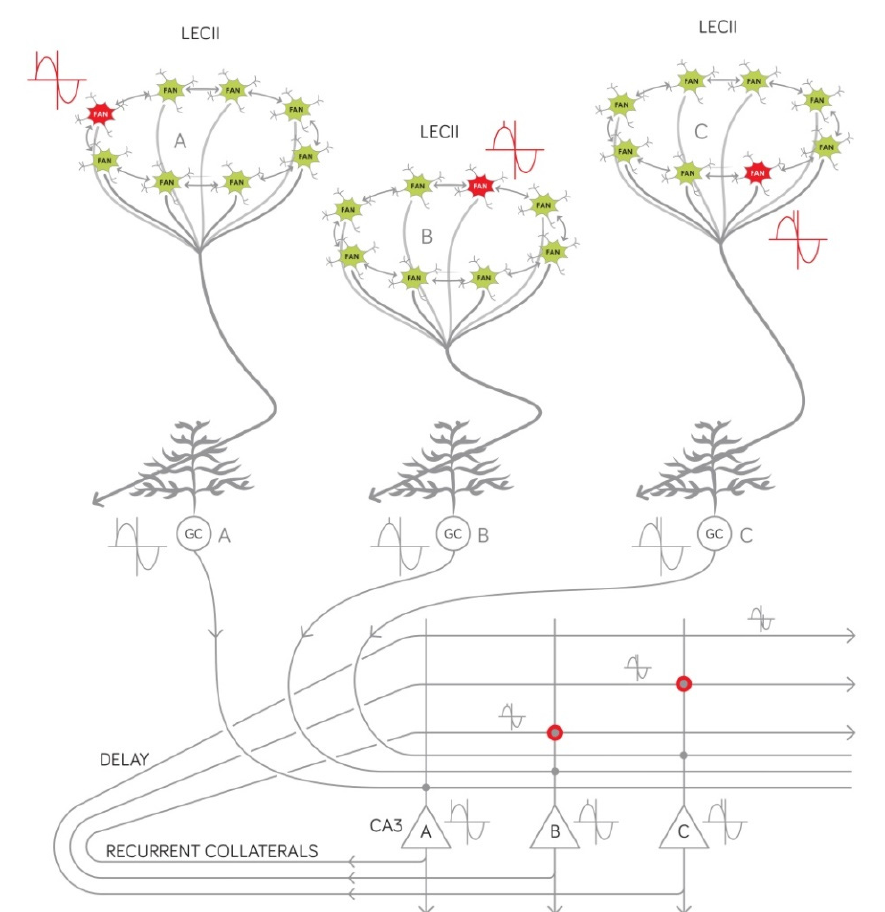
Figure 3. Molecular, cellular, and network mechanisms of encoding sequences. The internal temporal structure of any episodic memory is established by first assigning a theta phase (red inset diagram depicted next to the ring attractors) to each entity represented (three are shown in the Figure: A, B, and C) by a currently active EPISODE module. This theta phase serves to indicate whether the entity is upcoming, current, or already experienced and is repeated several times as several theta cycles unfold during the mnemonic episode to be encoded. As the temporal status of an entity (A, B, or C) changes, a directly measurable phenomenon, the so-called “phase precession” [59] is observed. Importantly, the generation and the repetition of the phase code in the entorhinal cortex is simply explained by the intrinsic electrophysiological and network properties of ring attractors. The theta phase is first transmitted to the dentate granule cells (depicted as “GC”) via the perforant pathway, then to the pyramidal CA3 neurons of the hippocampus via the mossy fibers as indicated by inset diagrams. Sequences are generated in the recurrent network of the CA3 using the phase code derived from the entorhinal EPISODE modules by the following mechanism: adjacent elements of the sequence produce coincident signals at the recurrent CA3-CA3 synapses given that the earlier signal (such as “A” in the Figure) suffers a delay when traveling along the recurrent collaterals and thus becomes coincident with a later one (such as “B” in the Figure) thereby making NMDA dependent plasticity possible (grey dot encircled with red). Sequences are generated by linking adjacent pairs first (in the Figure binding B to A and binding C to B is shown). The Figure is provided only to demonstrate the principle, therefore, several aspects are strongly simplified: (i) further cell types of the entorhinal ring attractors are not shown; (ii) the theta phase is also shifted during the entorhino–hippocampal transmission of the signal (inheritance of the phase precession), however, this results in the same amount of delay for all the entities (A, B, C) thus this aspect is not shown, and (iii) all the entities are represented by a population of cells, therefore, a population of “A” neurons becomes bound to a population of “B” neurons in CA3, etc.; however, for the sake of simplicity, only one neuron represents each population in the Figure. For details, the reader is referred to Reference [3].